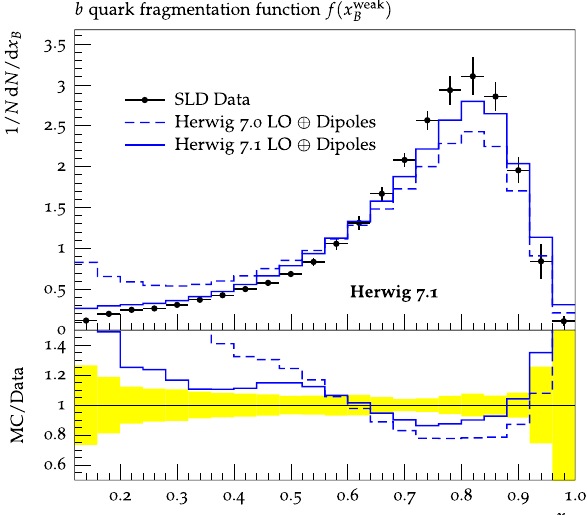
Fig. 5 The B -fragmentation as measured by SLD [26] and predicted by the dipole shower with the improved kinematics for massive